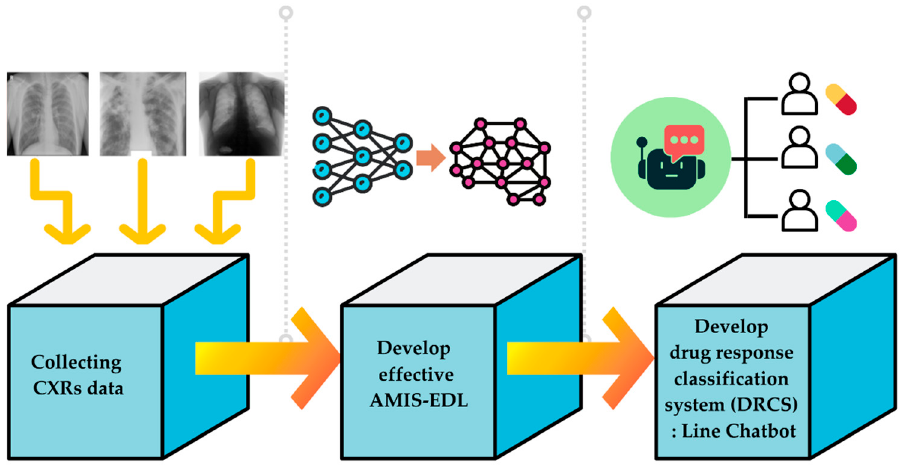
Figure 2. The development of drug response classification system (DRCS) (DBOQS).